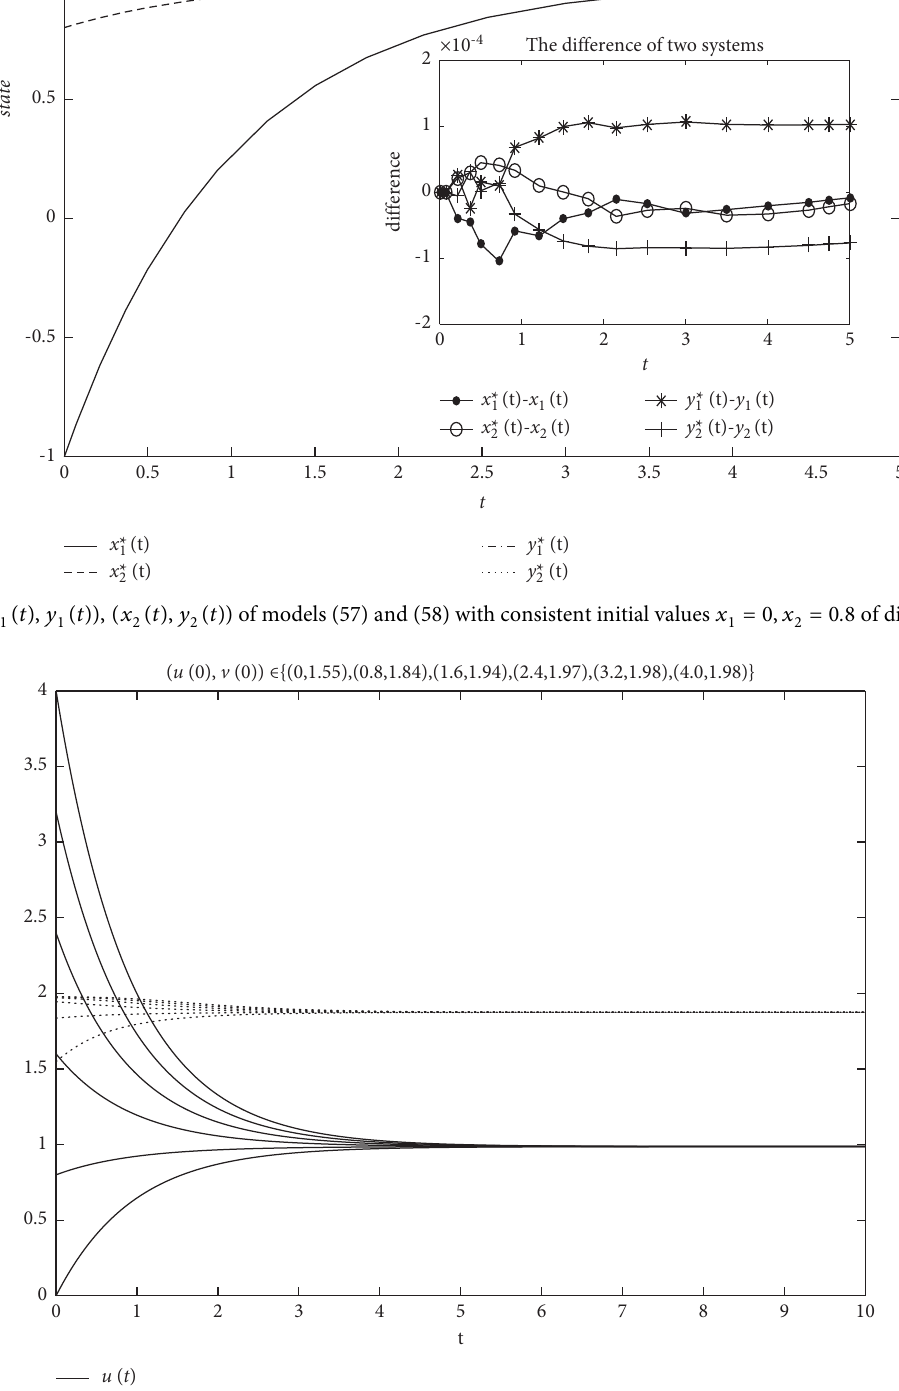
Figure 3: States u ( t ) and v ( t ) of model (36) with six groups of constant initial